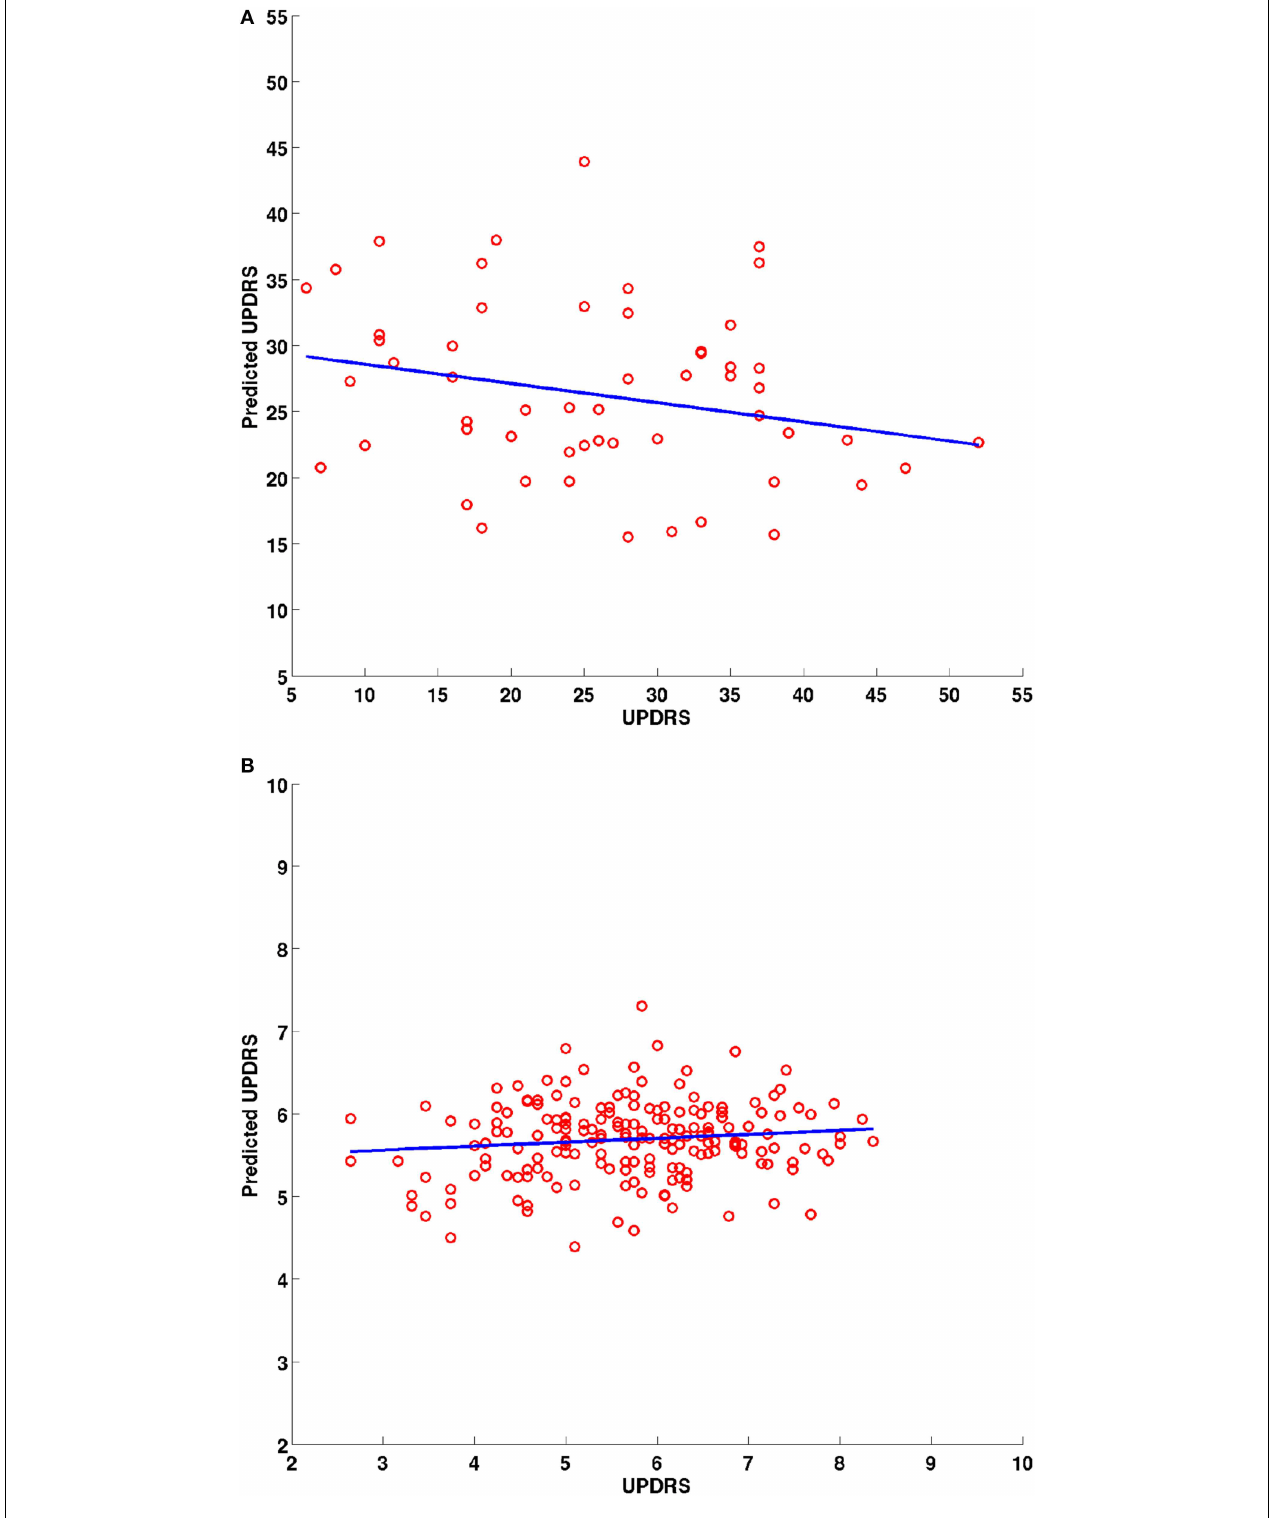
from all structures was combined. Experimental data from the (A) UBC dataset and (B) PPMI dataset. Blue line is the least squares fit between the predicted and actual clinical score